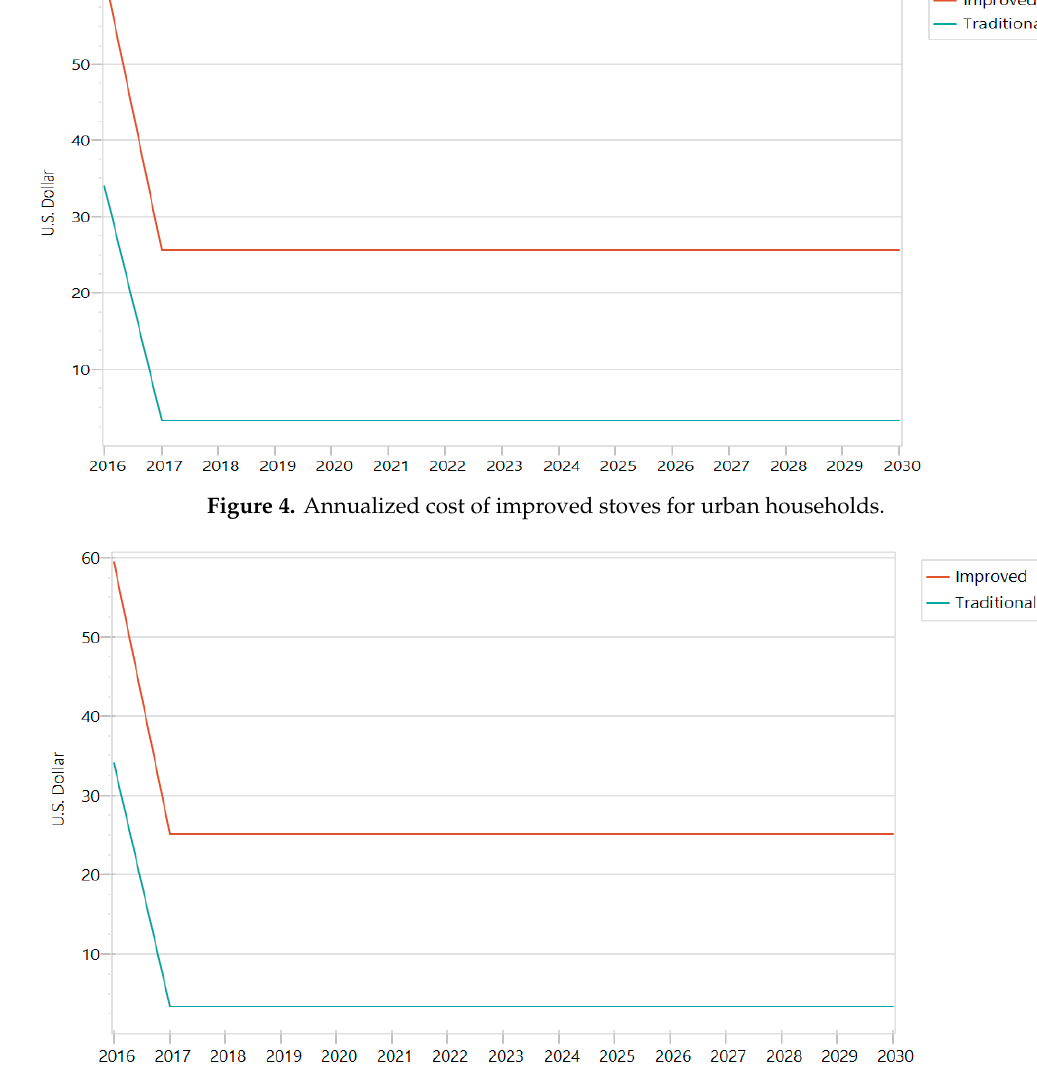
Figure 5. Annualized cost of improved stoves for rural households.